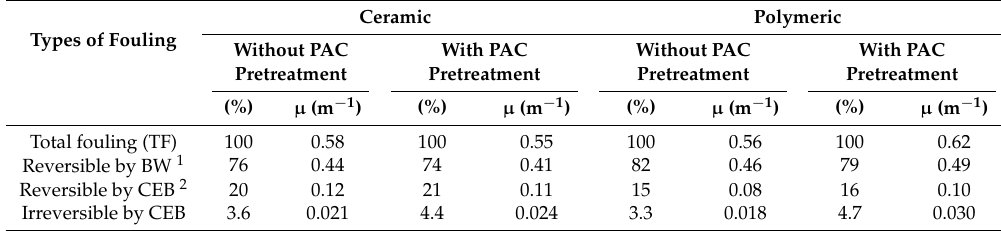
Table 5. Contributions (%) of fouling types for each membrane.